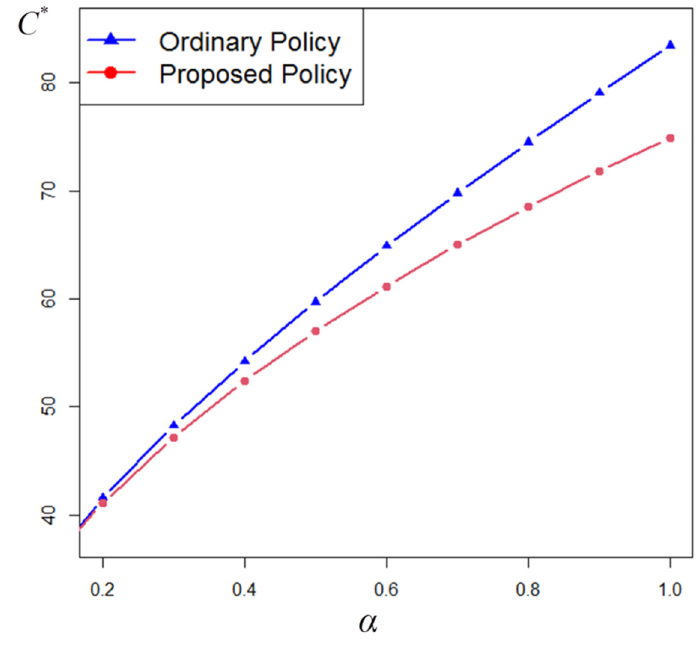
( 1 ) α = 1, when Figure 3. The minimum cost rates of the two policies for different values of α when c GPP